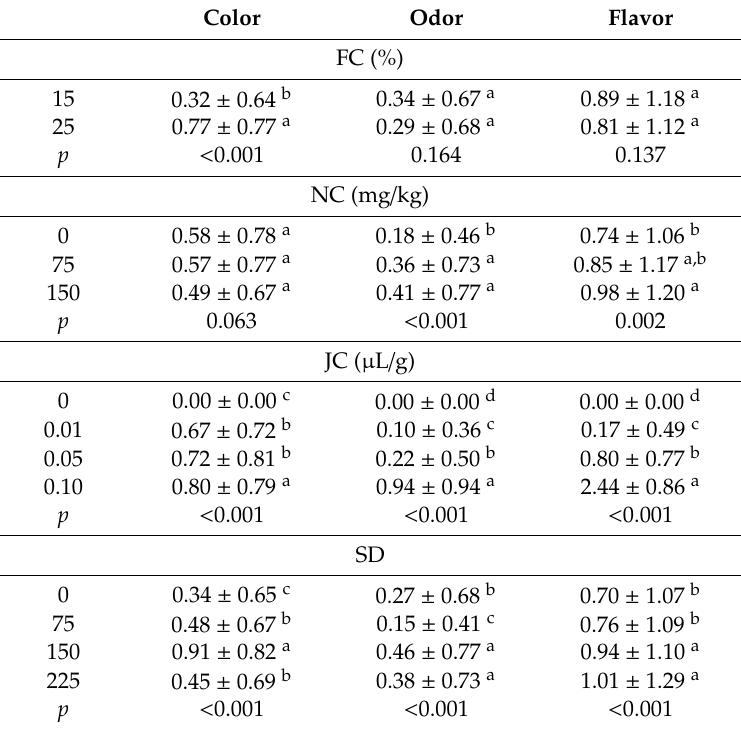
Table 5. Sensory parameters of dry fermented